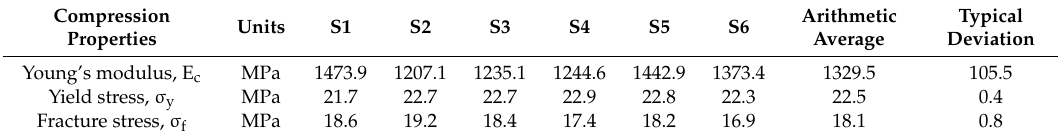
Table 7. Elastic and mechanical properties of PETG for each Z-axis specimen.